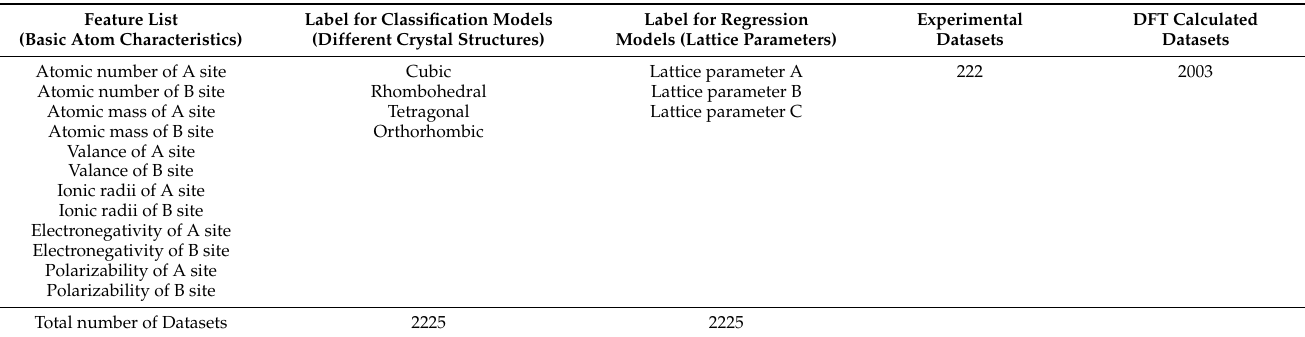
Table 1. Current database features and labels for the